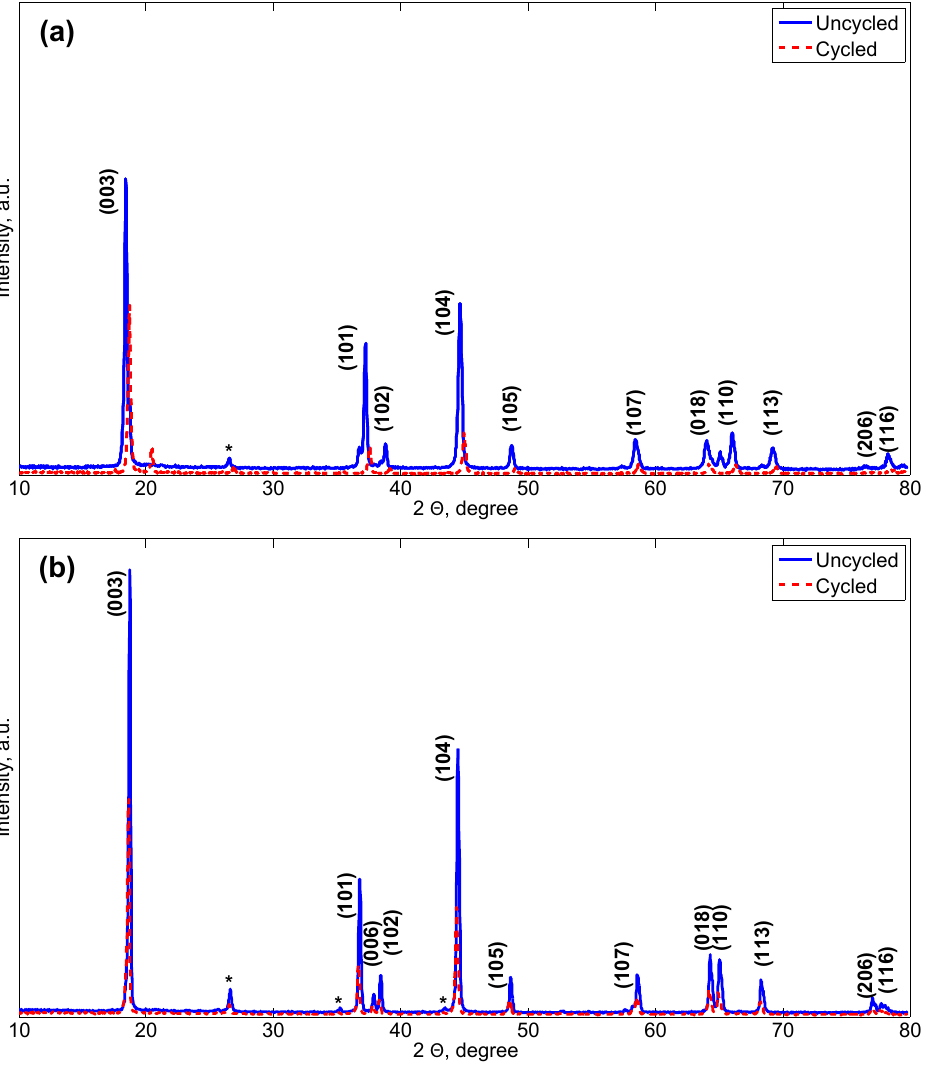
Figure 3. XRD patterns of the uncycled and cycled NMC electrodes in ( a ) their lithiated states and ( b ) delithiated